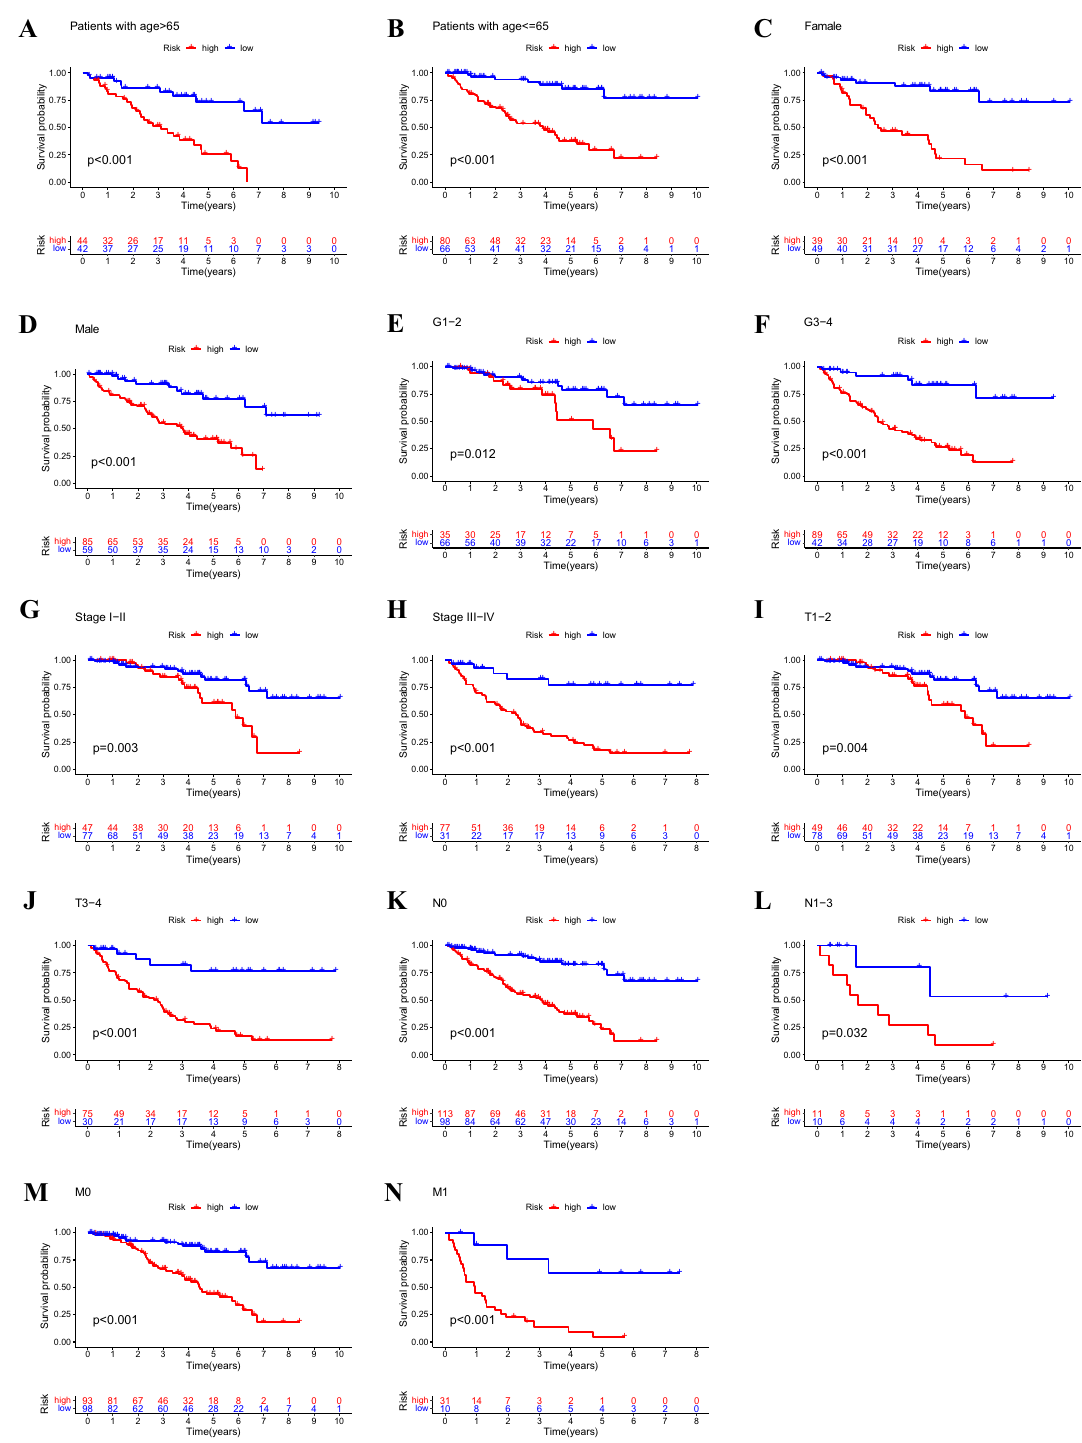
Figure 5. Kaplan–Meier survival curves for high-risk and low-risk groups in patients divided according to different clinicopathological variable classifications. ( A , B ) Age. ( C , D ) Gender. ( E , F ) Grade. ( G , H ) Stage. ( I , J ) T stage. ( K , L ) N stage. ( M , N ) M stage. T, tumour; N, lymph node; M,